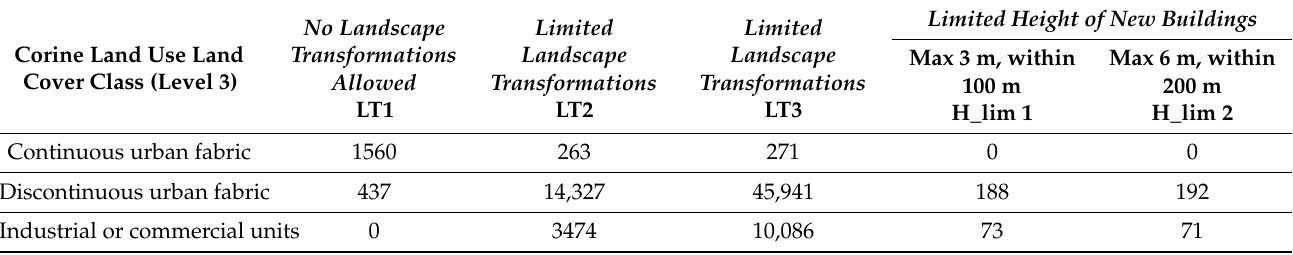
Figure 10. Maps of the different proposed norms: LT4. Table 3. Extent in hectares of land-use/land cover categories for each proposed norm (ha). High- lighted in green the most frequent categories.